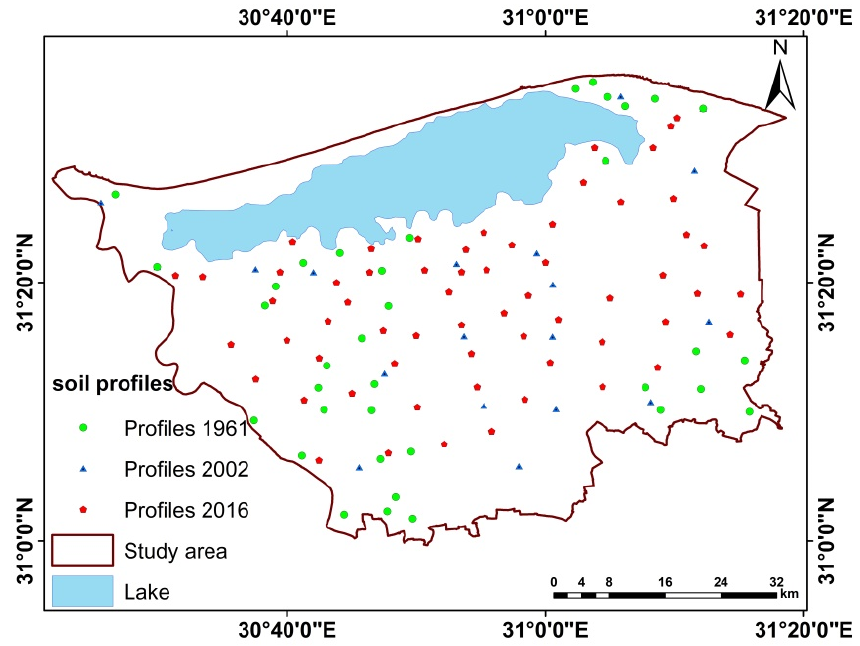
Figure 2. Location of the soil profiles in the study area.